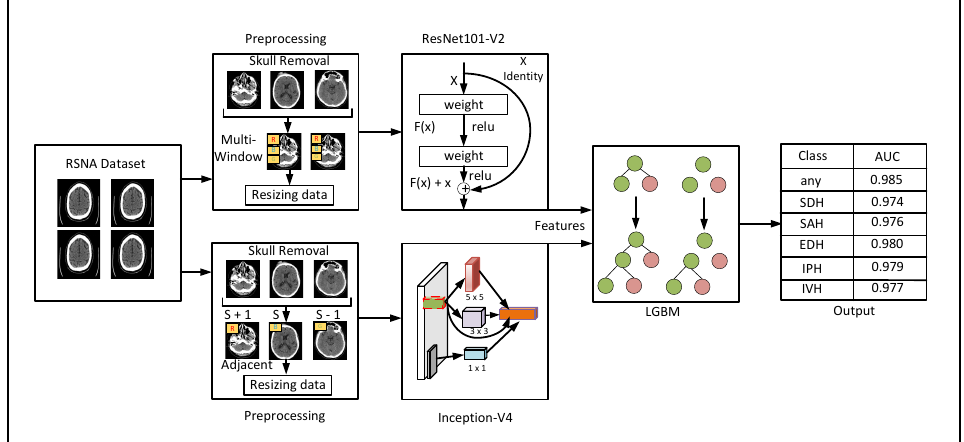
Figure 1. Systematic view of the proposed methodology for detection and subtype classification of